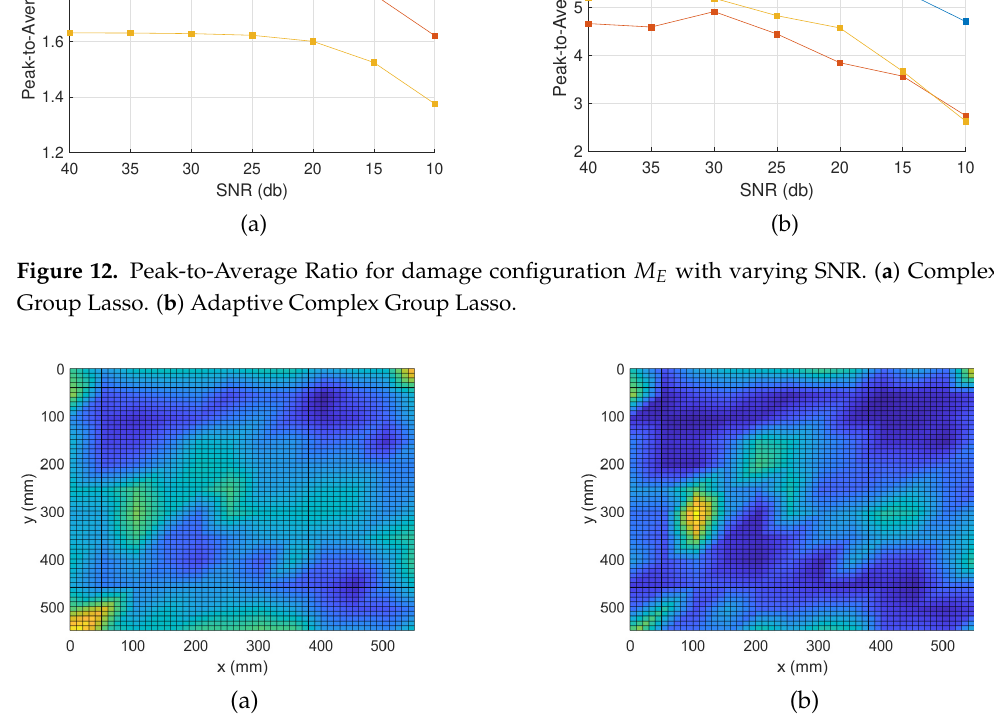
Figure 13. Damage Detection for M 1 : 1 point-like mass and SNR of 15 db. ( a ) Complex Group Lasso. ( b ) Adaptive Complex Group